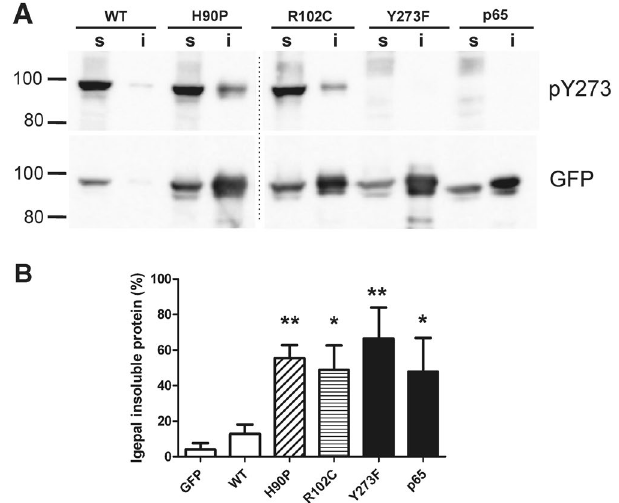
Figure 5. Differential aggregation of wild type and mutant DYRK1B variants. HeLa cells expressing wild type or mutant GFP-DYRK1B constructs were grown in 6-well plates and lysed using the non-denaturing immunoprecipation buffer with 0.5% Igepal CA-630. Lysates were centrifuged, and the distribution of the GFP proteins in the soluble and insoluble fraction was analysed by immunoblotting and by measuring GFP autofluorescence with the help of a microplate reader. ( A ) Western blot analysis. The gel was loaded with aliquots of the supernatants (24% of the total sample) and the pellets (50%). The dotted line indicates where irrelevant lanes were deleted from the final image. ( B ) Evaluation of GFP fluorescence measurements. Significant differences between WT and mutant DYRK1B are marked (two-tailed t-test, * p < 0.05, ** p < 0.01) (means and SD, n =